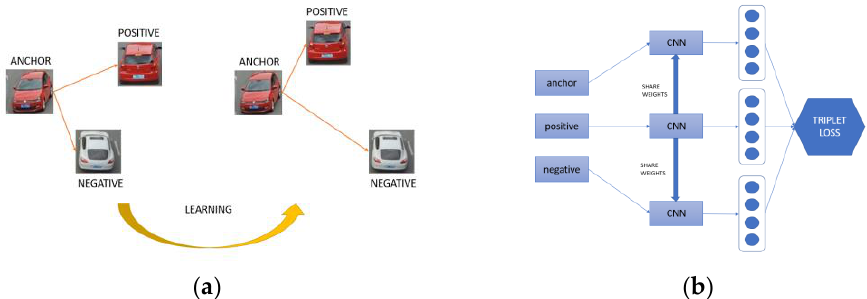
Figure 5. Representation of the “anchor” ( a ) and a network that applies the triplet loss function ( b